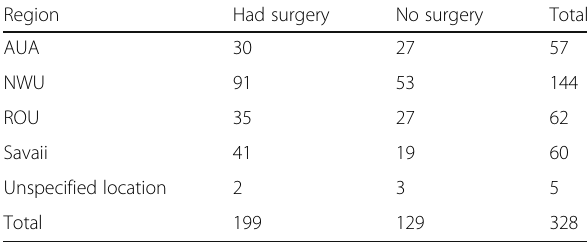
Table 4 Surgery status of men with hydroceole by region Region Had